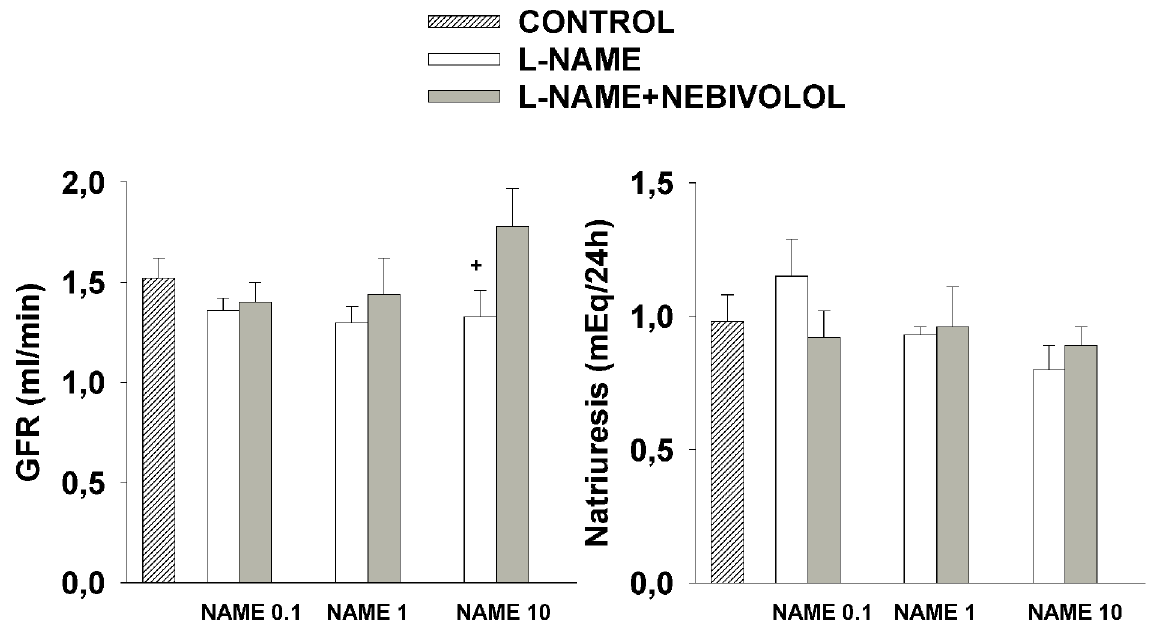
FIGURE 3 . Glomerular filtration rate (left) and sodium excretion (right) after 2 weeks of treatment. +, p < 0.05 vs. L- NAME–treated group.